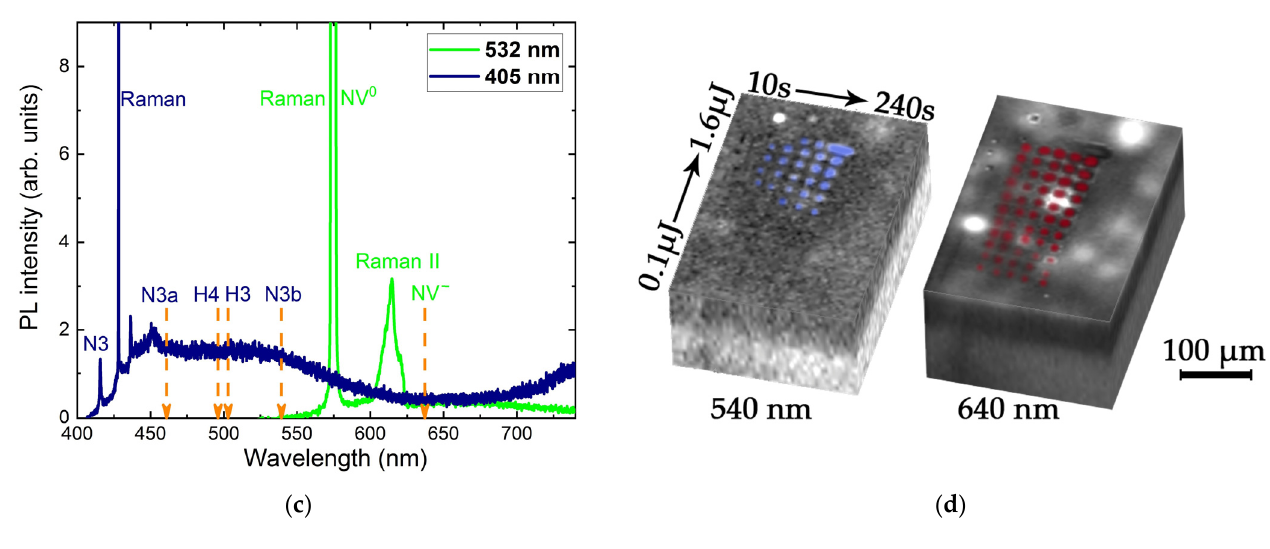
Figure 1. ( a ) Spectral characterization of the initial diamond sample: FT-IR spectrum (spectral assignment after); ( b ) visible transmission spectrum; ( c ) PL spectra at 405 nm and 532 nm laser excitation; ( d ) 3D-confocal image of micromarks array in PL spectra of the diamond (540 nm and 640 nm).